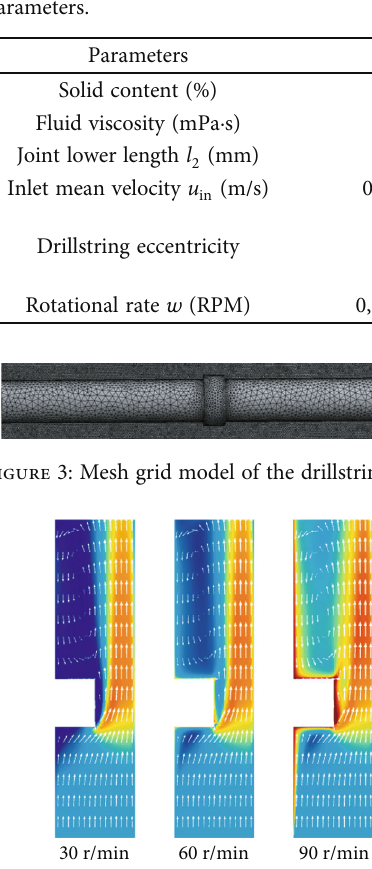
Figure 4: Flow fi eld distribution at joint at di ff erent drillstring rotational